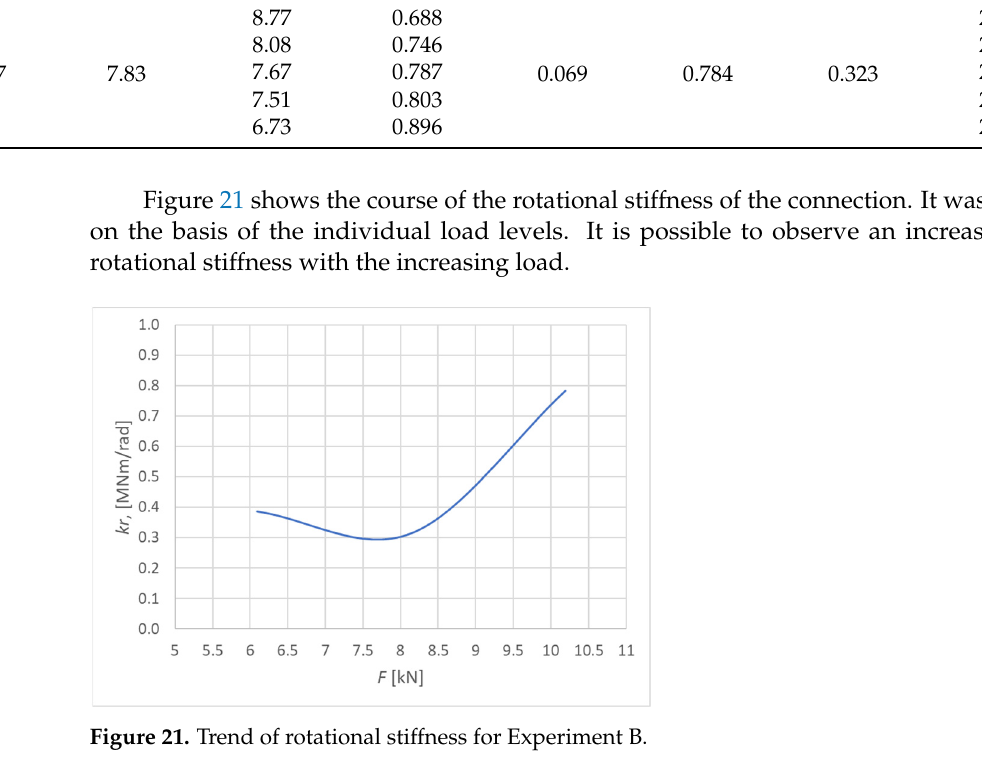
Figure 22. Load–deformation curves of quasi ‐ static numerical modeling for individual specimens made from a combination of bolts and dowels (Experiment A). Figure 23 shows the normal stress perpendicular to the grain in the individual ele ‐ ments of the connection at a load level of 60% ULS. As can be seen, the maximum tensile stress perpendicular to the grain (1 MPa) is locally concentrated mainly near the holes.